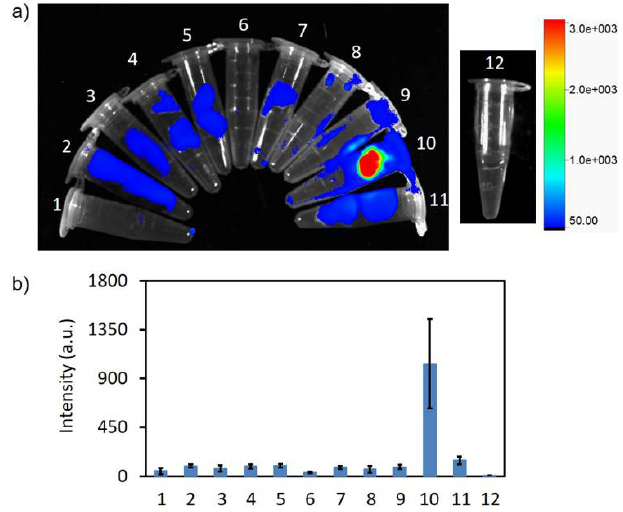
Figure 1. ( a ) Overlay of ex vivo fluorescence imaging and bright field image of the collected